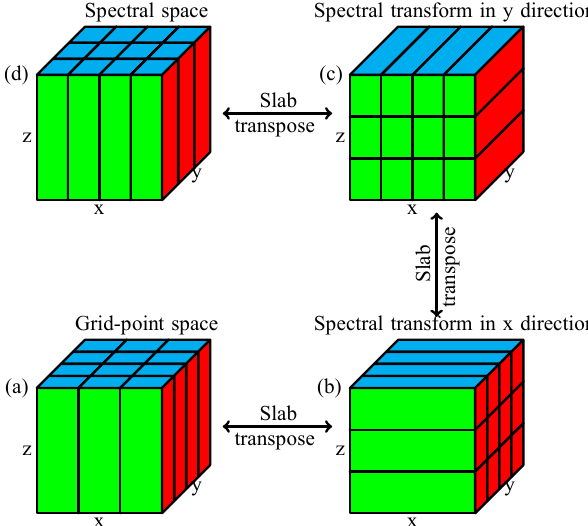
Figure 3. Parallel scheme of regional spectral model: (a) 2-D de- composition of 3-D grid field with cx/cy cores in the x/y direction, (b) 2-D decomposition of 3-D grid field with cy/cx cores in the y/z direction, (c) 2-D decomposition of 3-D grid field with cy/cx cores in the x/z direction, and (d) 2-D decomposition of 3-D grid field with cy/cx cores in the x/y direction. Transposition between (a) and (b) can be conducted by cy -independent xz slab MPI trans- positions, transposition between (b) and (c) can be conducted by cx -independent xy slab MPI transpositions, and transposition be- tween (c) and (d) can be conducted by cy -independent yz slab MPI